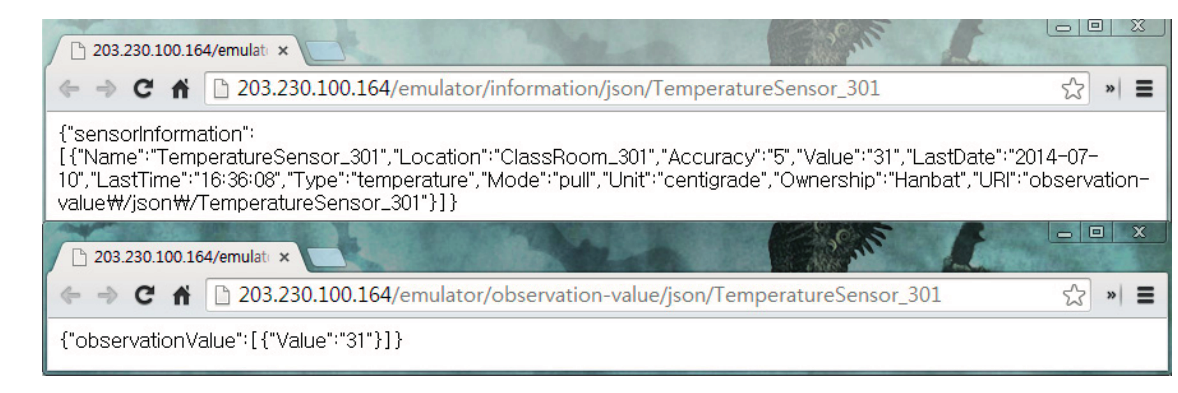
Figure 7. Abstracted object